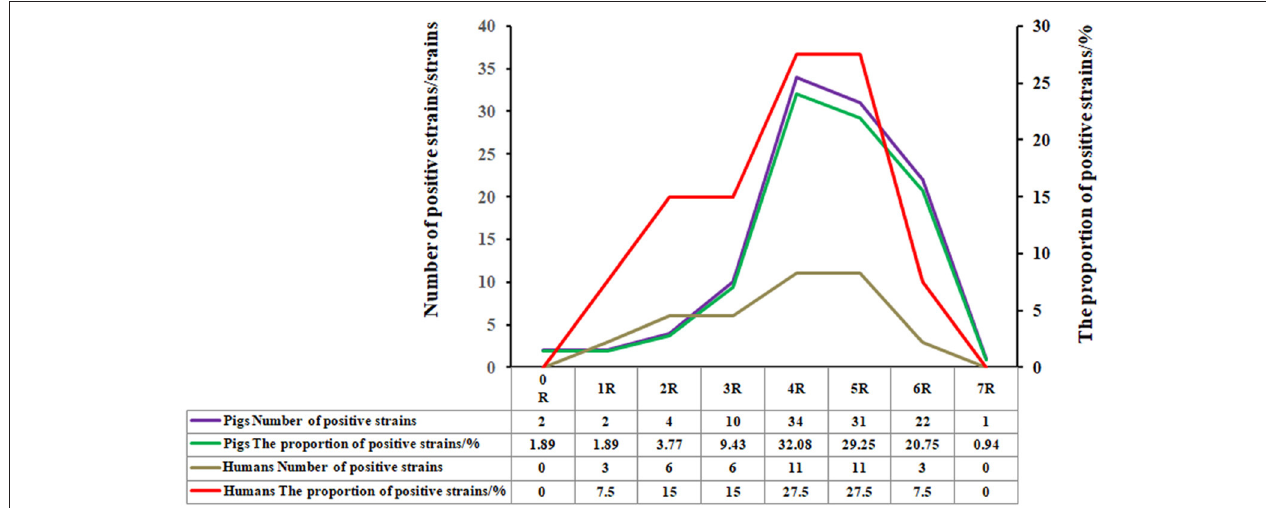
FIGURE 2 | Percentage of the E. coli strains from swines with no, one, or multiple drug resistance. Among the 106 E. coli strains isolated from swines, 98 strains displayed multi-drug resistance (i.e., resistance to three or more classes of antibiotics at the same time), accounting for 92.45% of the total isolates. Among them, the four classes of antibiotics-resistant (4R) strains were the most common ones, accounting for 32.08% (34/106), followed by strains resistant to the five classes of antibiotics-resistant (5R), accounting for 29.25% (31/106), resistant to the six classes of antibiotics resistant (6R), and the seven classes of antibiotics-resistant (7R), occupying 20.75% (22/106), and 0.94% (1/106), respectively.